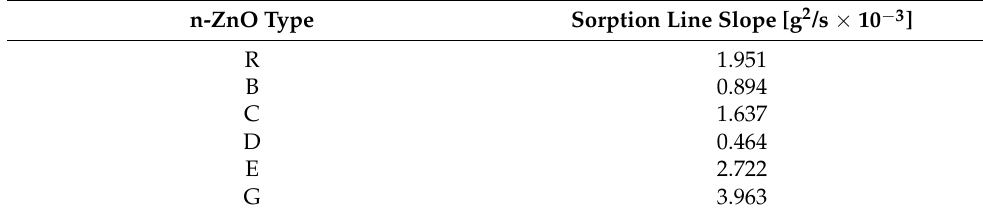
Table 6. Squalene sorption line slopes for the different ZnO